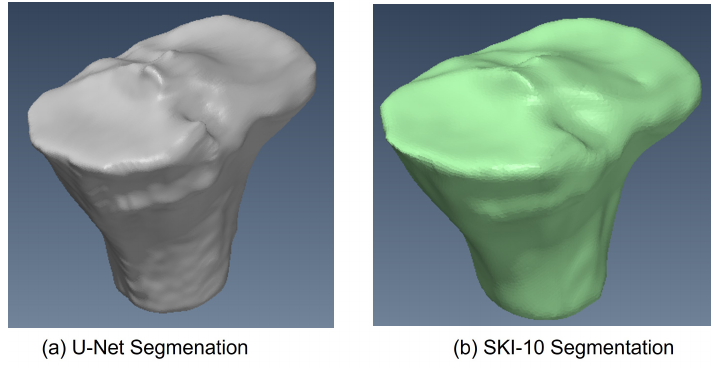
Figure 12. Tibia 3D mesh model produced by ( a ) U-Net and ( b ) the SKI10 ground truth.